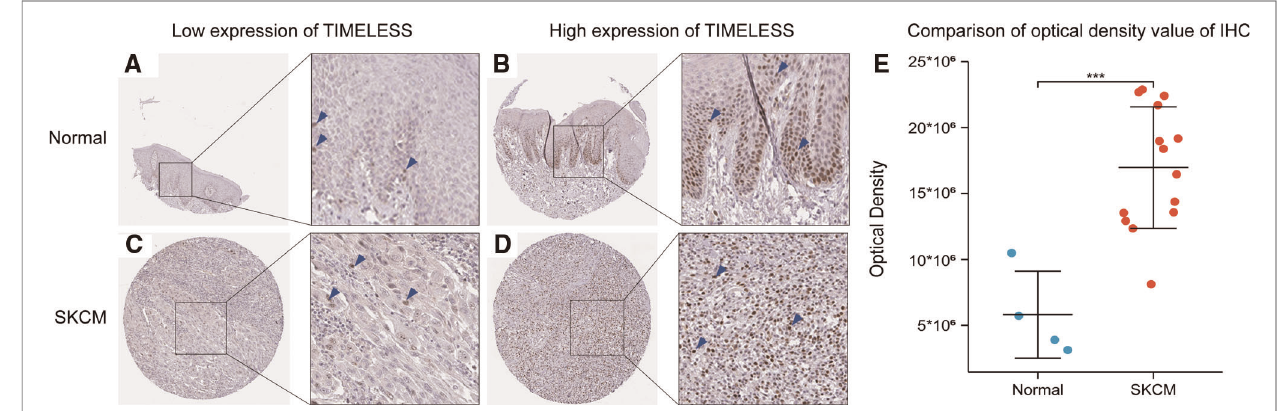
FIGURE 7 | Representative IHC staining images of TIM in SKCM tissues and normal skin controls. ( A,B ) TIM was low ( A ) or high ( B ) in normal skin tissues. ( C,D ) TIM was low ( A ) or high ( B ) in SKCM tissues. ( E ) comparison of optical density value of IHC between SKCM tissues and normal skin controls. Blue arrows indicate positive